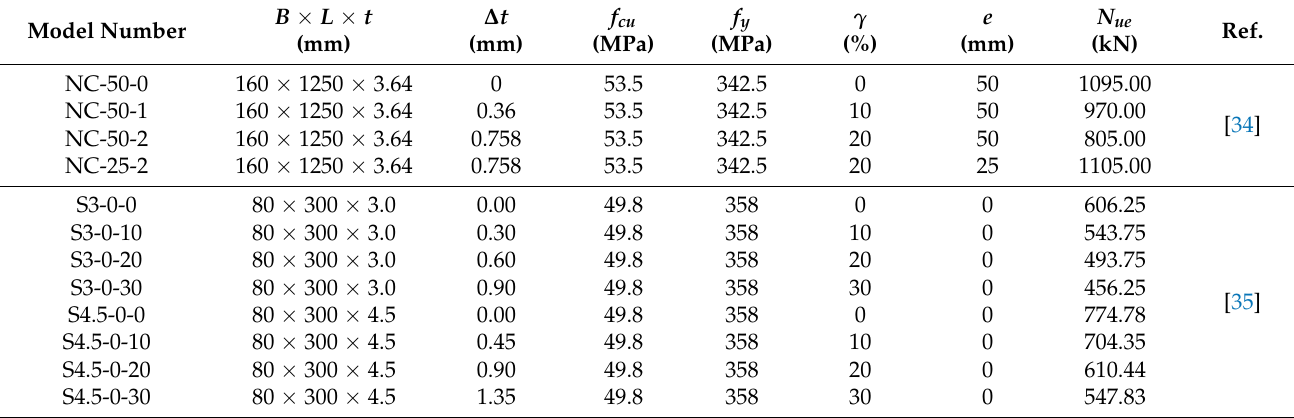
Table 1. The main design parameters in [35].